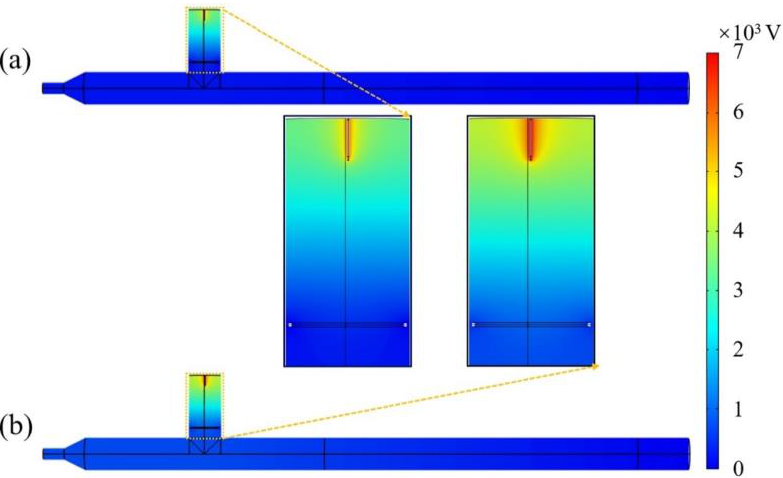
Figure 4. Potential distributions with different applied voltages on the nozzle and ring electrodes: ( a ) nozzle voltage of 6000 V, ring grounded; ( b ) nozzle voltage of 7000 V, ring voltage of 500 V. Operating conditions: N 2 flow rate is 4 L/min, and the droplet charge number is 1.84 × 10 − 13 C.